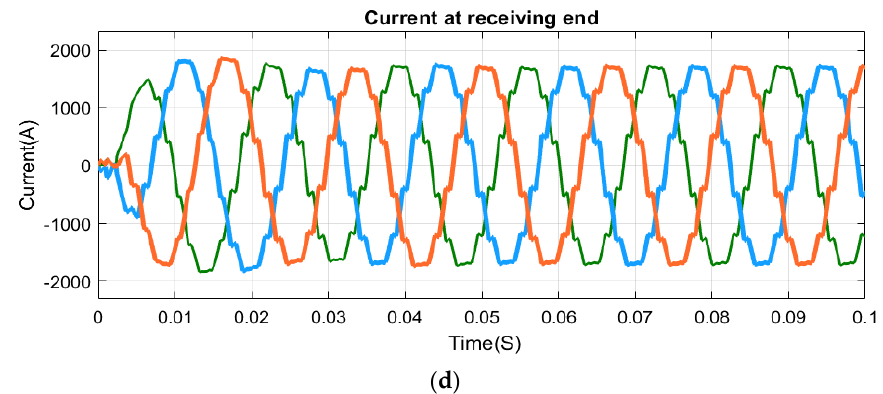
Figure 6. ( a ) Voltage waveform at sending end. ( b ) Current waveform at sending end. ( c ) Voltage waveform at receiving end without harmonic filters. ( d ) Current waveform at receiving end without harmonic filters. A Three-phase circuit breaker is used to connect the filters in and out of the system during simulation. By connecting the harmonic filters, the waveforms shown in Figure 7 are obtained.